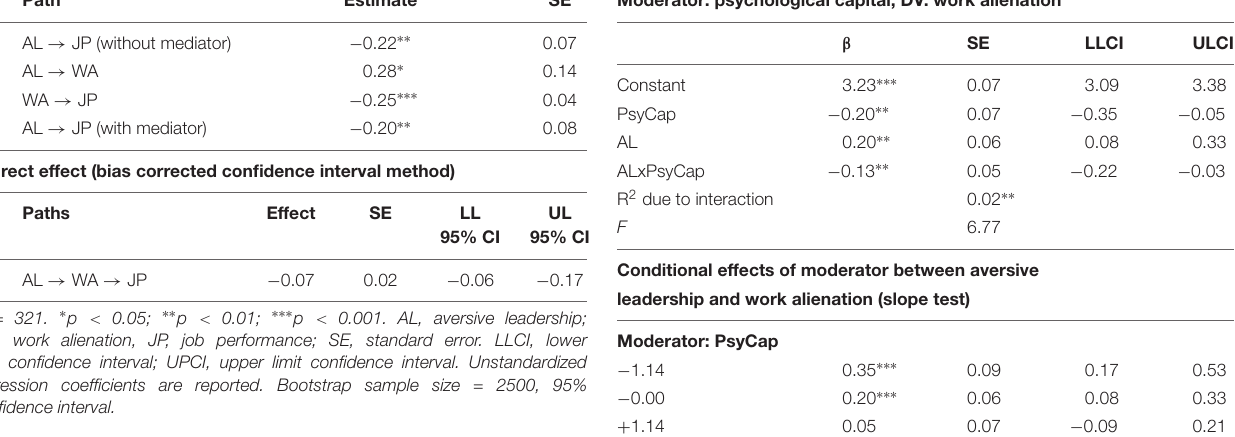
TABLE 3 | Bootstrap results for direct and indirect effects.